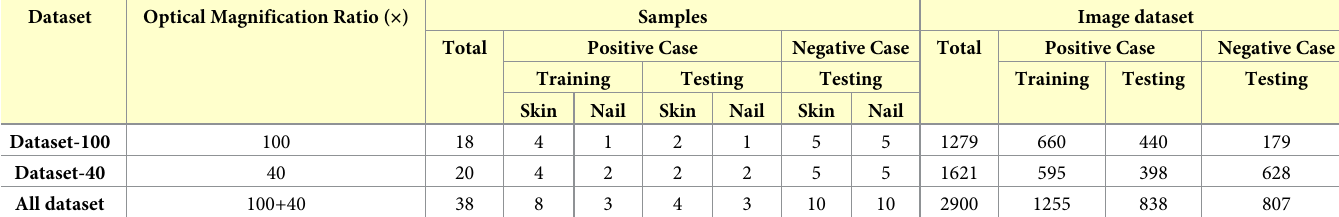
Table 1. Summary of fungus hyphae